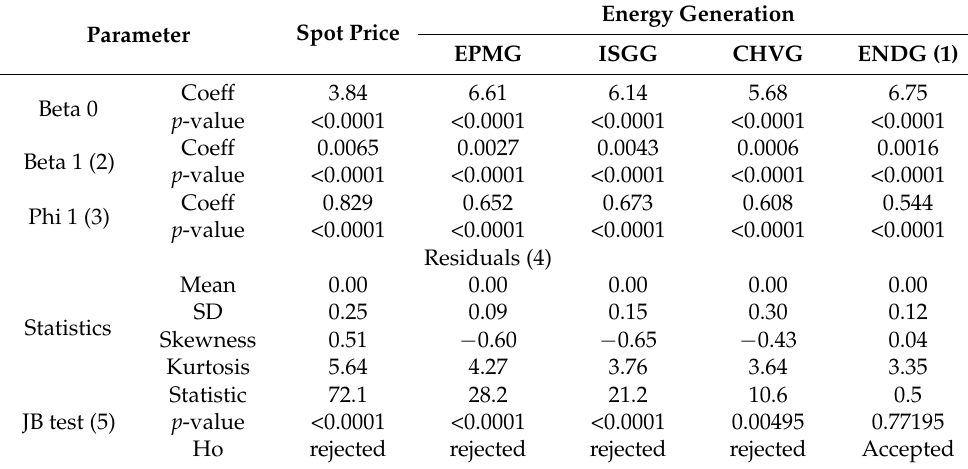
Table 3. Estimates for the deterministic trend and AR(1) component of the (log)series.